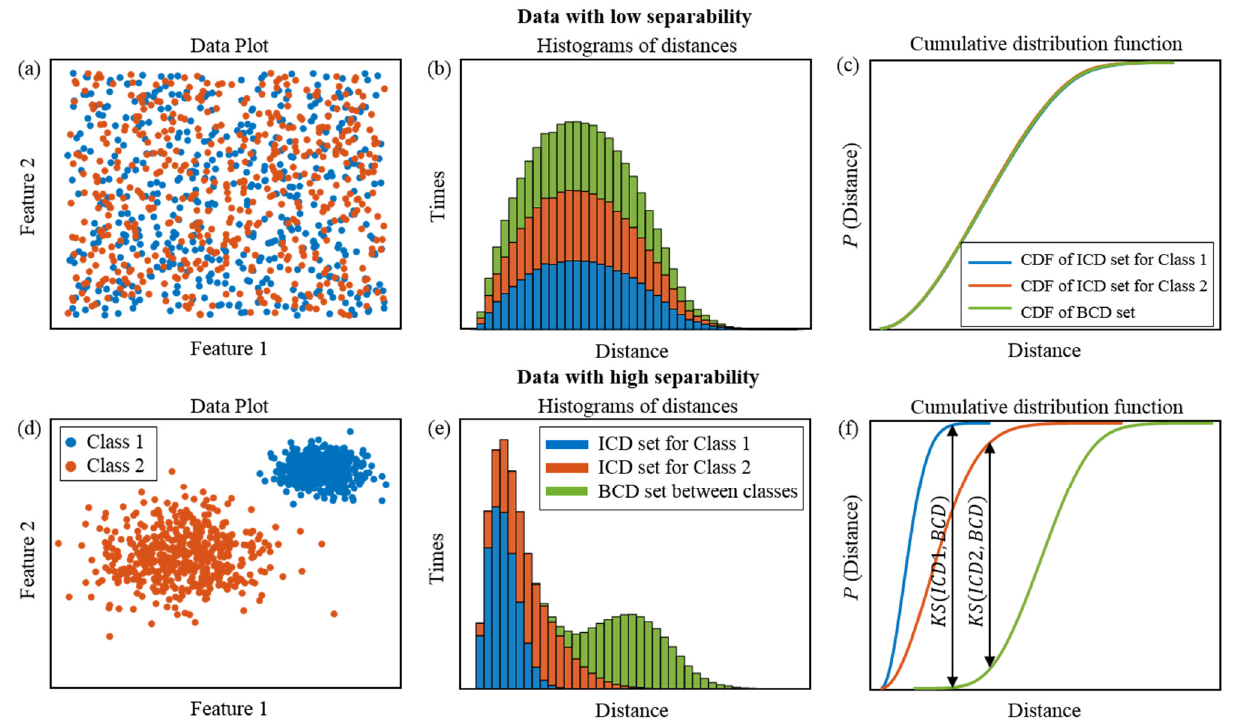
Figure 2. The two-class dataset and their ICD and BCD set distribution: ( a – c ) the data plot, the histograms of distances and empirical cumulative distribution functions of low separability dataset, ( d – f ) the data plot, the histograms of distances and empirical cumulative distribution functions of high separability dataset.